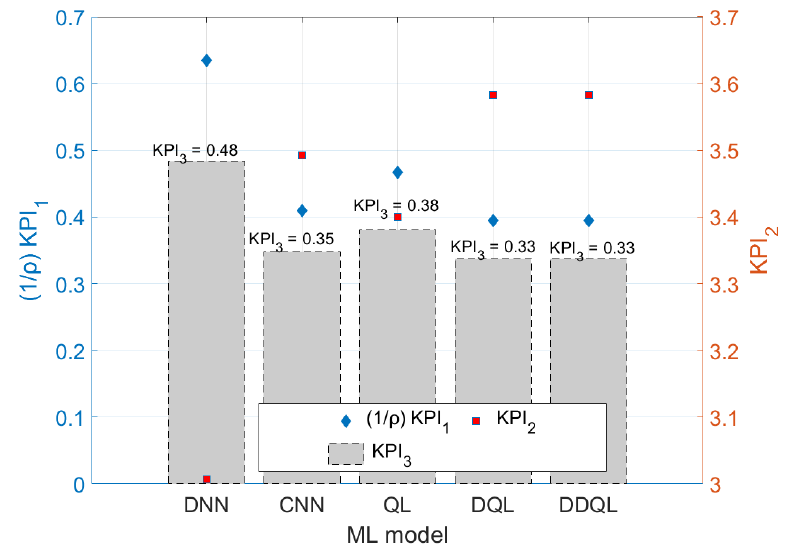
Figure 9. Performance comparison of different ML models for RRM. The normalized KPI 1 is represented on the left axis and KPI 2 is on the right axis, while the gray bars represent the value obtained from the computation represented by KPI 3